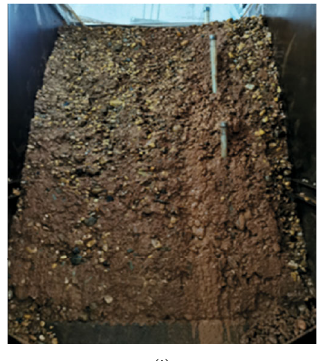
Figure 6: Slope morphology diagram at the end of slope erosion: (a) 30%-1:2.5-140 (1 h); (b) 50%-1 :2.5-180 (1 h); (c) 70%-1 :2.5-100 (1 h); (d) 70%-1 :1.5-180 (1 h); (h); (e) 30%-1:1.5-100 (1 h); (f) 50%-1:1.5-180 (1 h); (g) 50%-1:0.5-100 (20min); (h) 30%-1: 0.5-180 (1 h); (i) 70%-1 :0.5-140 (13 min).